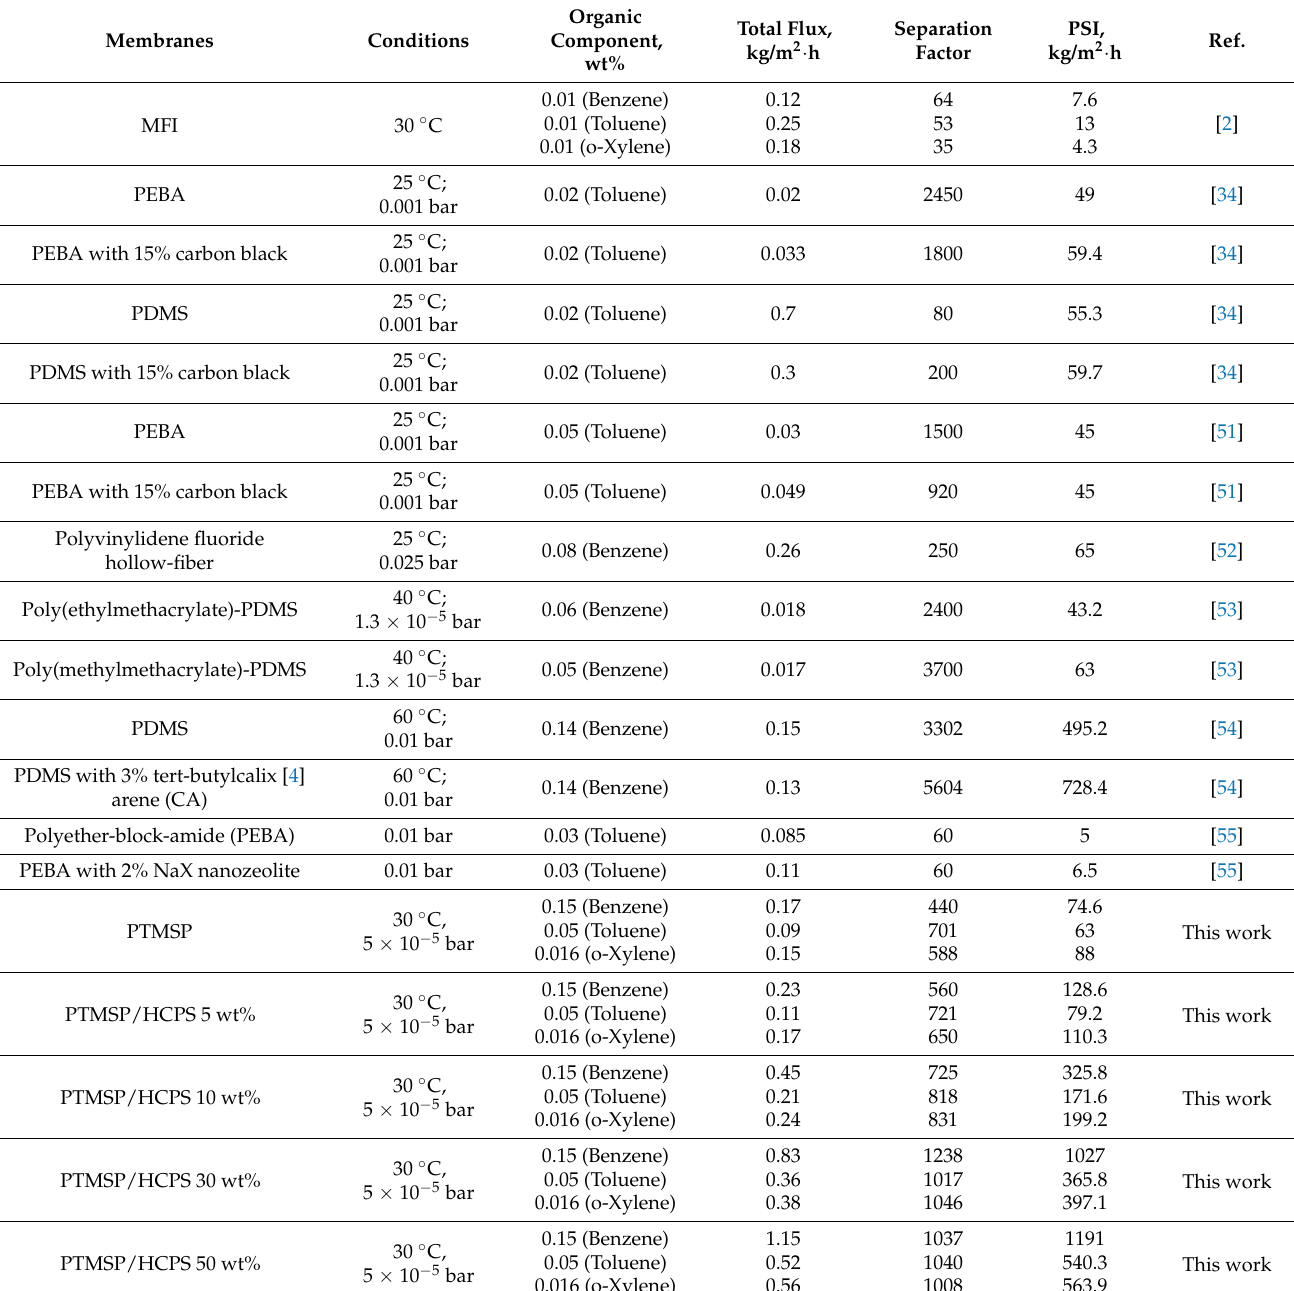
Table 1. Comparison of pervaporation